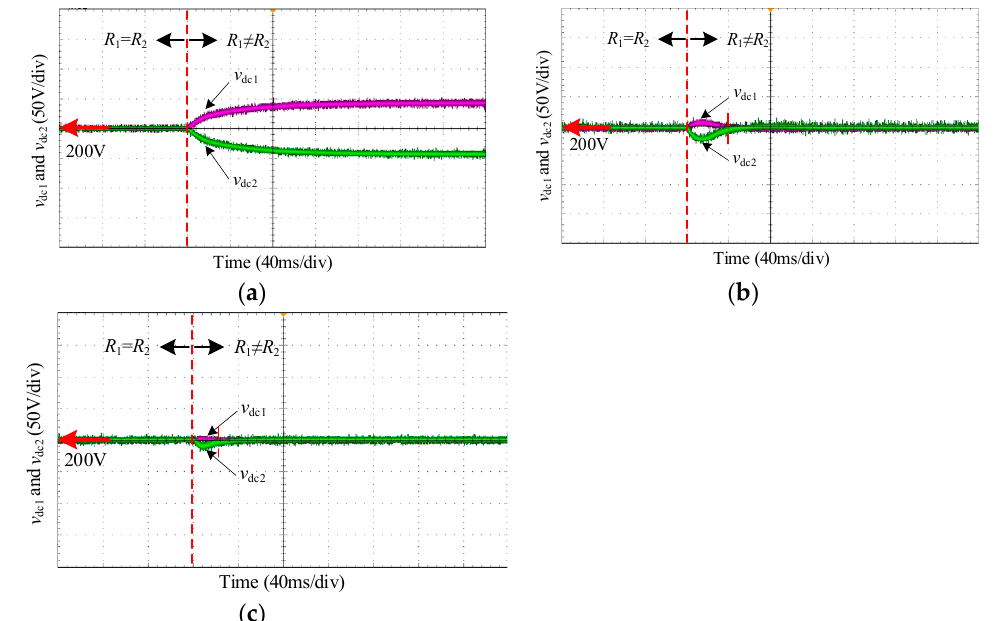
Figure 11. Performance comparison of the two strategies when the loads jump from equal to unequal. ( a ) No NPV control strategy is adopted; ( b ) ZSV-J; ( c ) The proposed NPV control strategy.